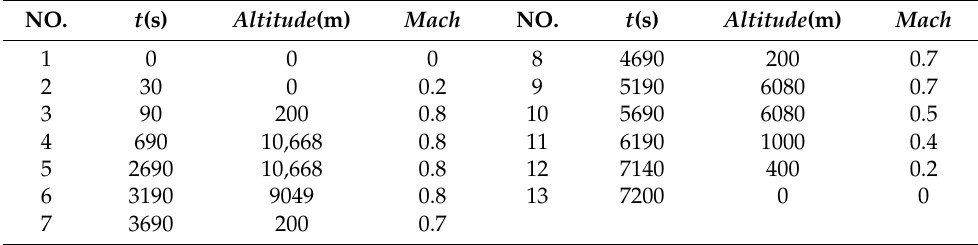
Figure 1. Flight mission profile of a fighter jet [18]. Table 1. State of flight mission phases.